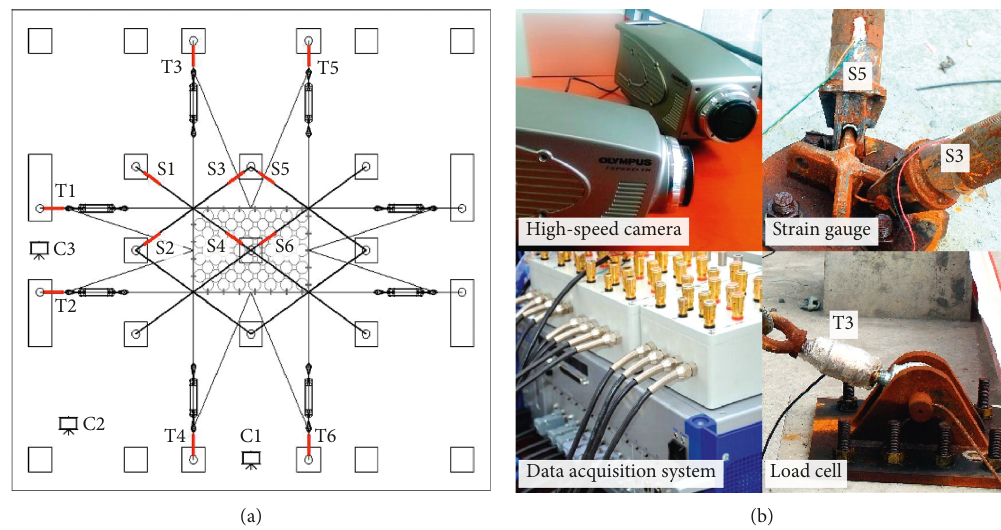
Figure 10: Measured points and test instruments. (a) Layout of all the measured points. (b) Partial test instruments. Spring (compression)